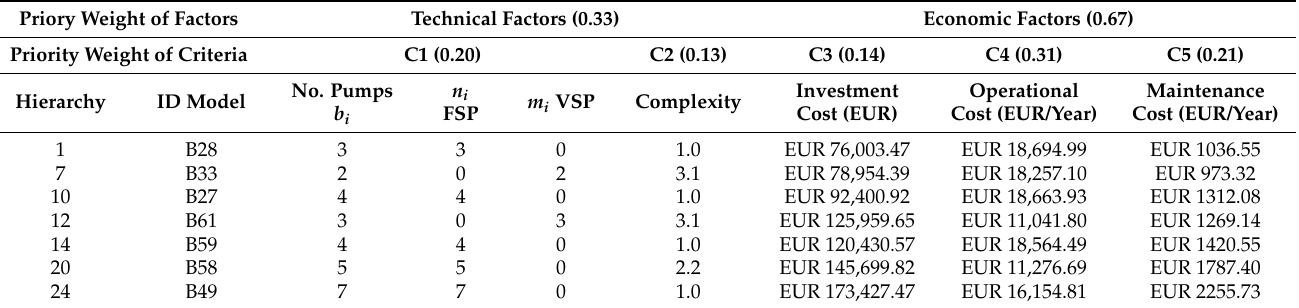
Table 14. Assessment of the criteria for each alternative (CAT-PS3).